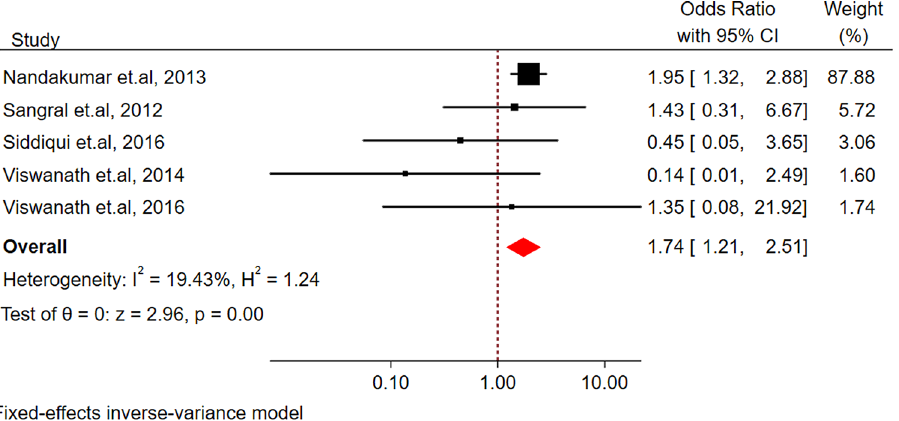
Figure 2. Forest plot for the association between diabetes and mortality among tuberculosis patients in South Asia.